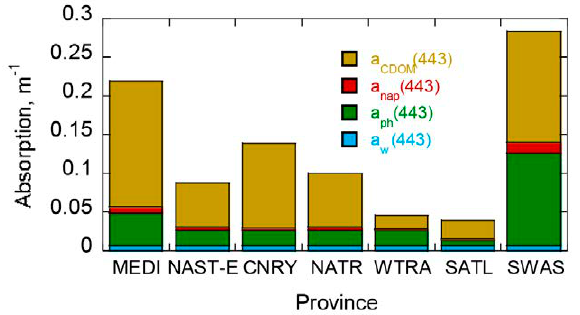
Fig. 9. – Average contribution to total light absorption (m –1 ) at 443 nm of CDOM [a (443)], non-phytoplankton particles [a CDOM phytoplankton [a (443)] and water(a ) for the different ph w